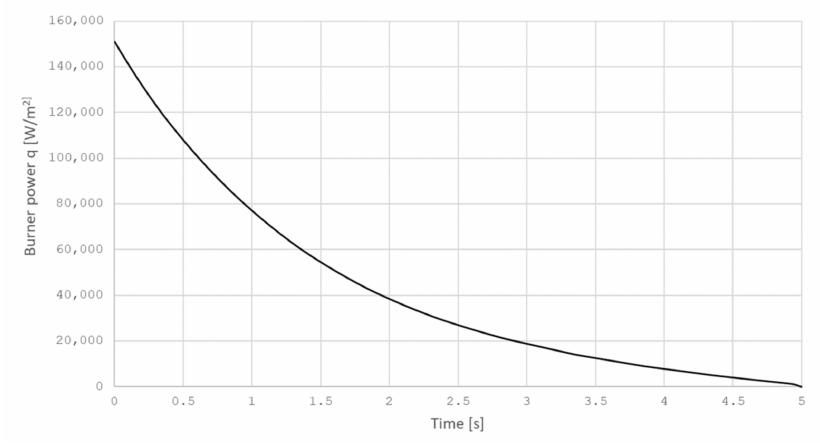
Figure 11. Values q max versus time.